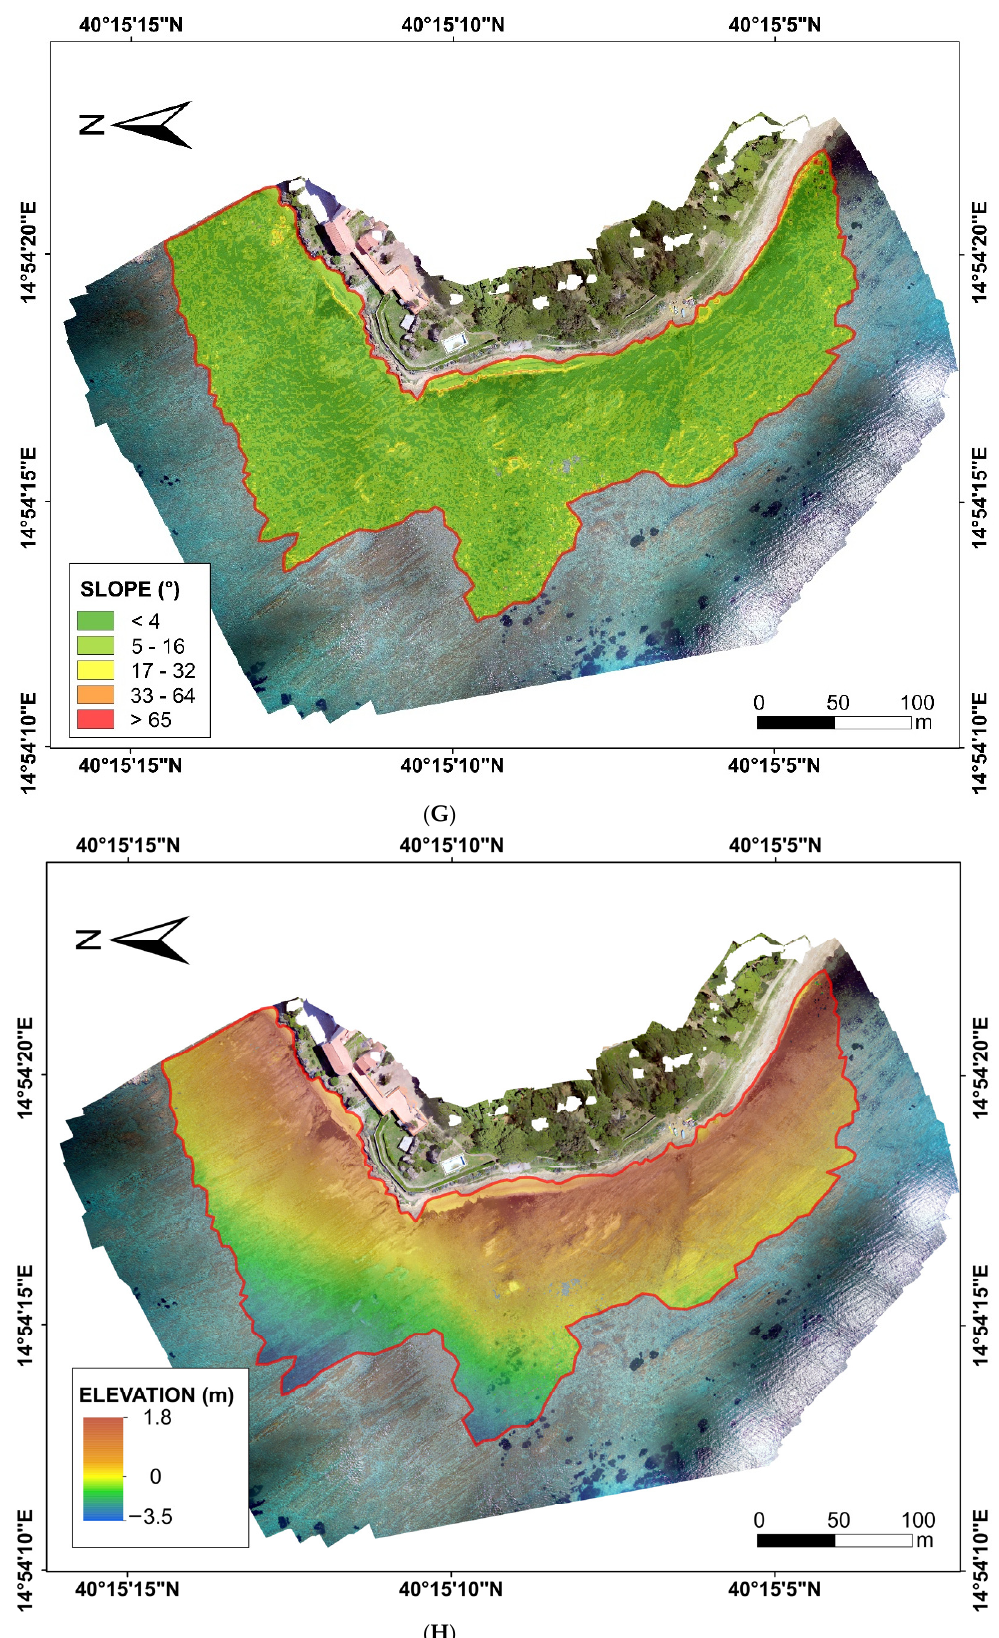
Figure 6. Main characteristics of the Punta Ogliastro site: ( A ) investigated platform; ( B ) slope in degrees; ( C ) elevation in meters; ( D ) Side Scan Sonar analysis; ( E ) dense cloud of the emerged and